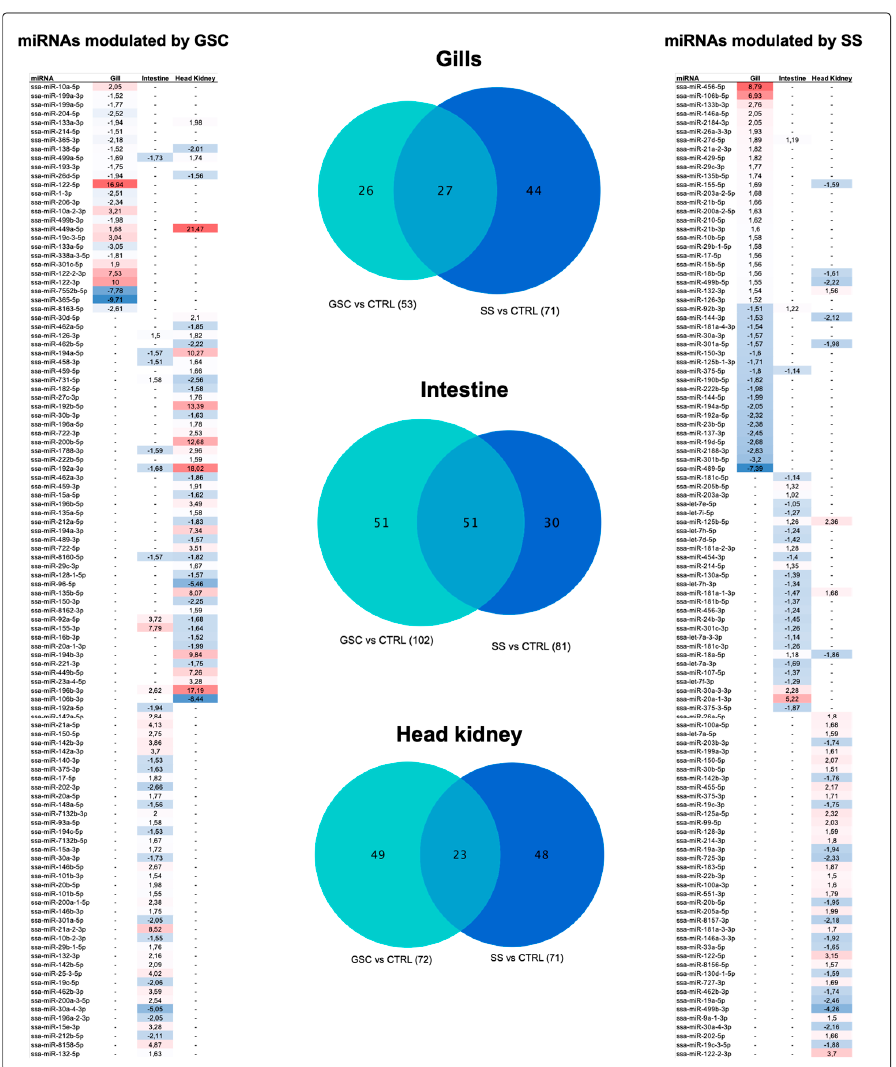
Figure 7. miRNA differential expression analysis of Atlantic salmon tissues under both conditions, GSC and SS. Tables show the fold-change values of miRNA for each tissue; red: upregulated, blue: